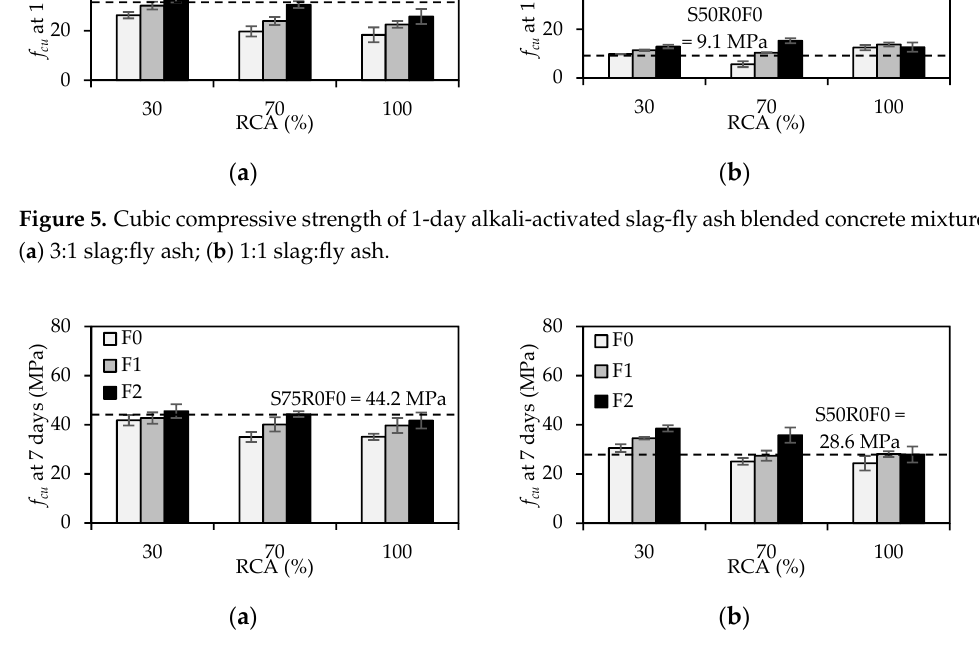
Figure 6. Cubic compressive strength of 7-day alkali-activated slag-fly ash blended concrete mixtures: ( a ) 3:1 slag:fly ash; ( b ) 1:1 slag:fly ash.